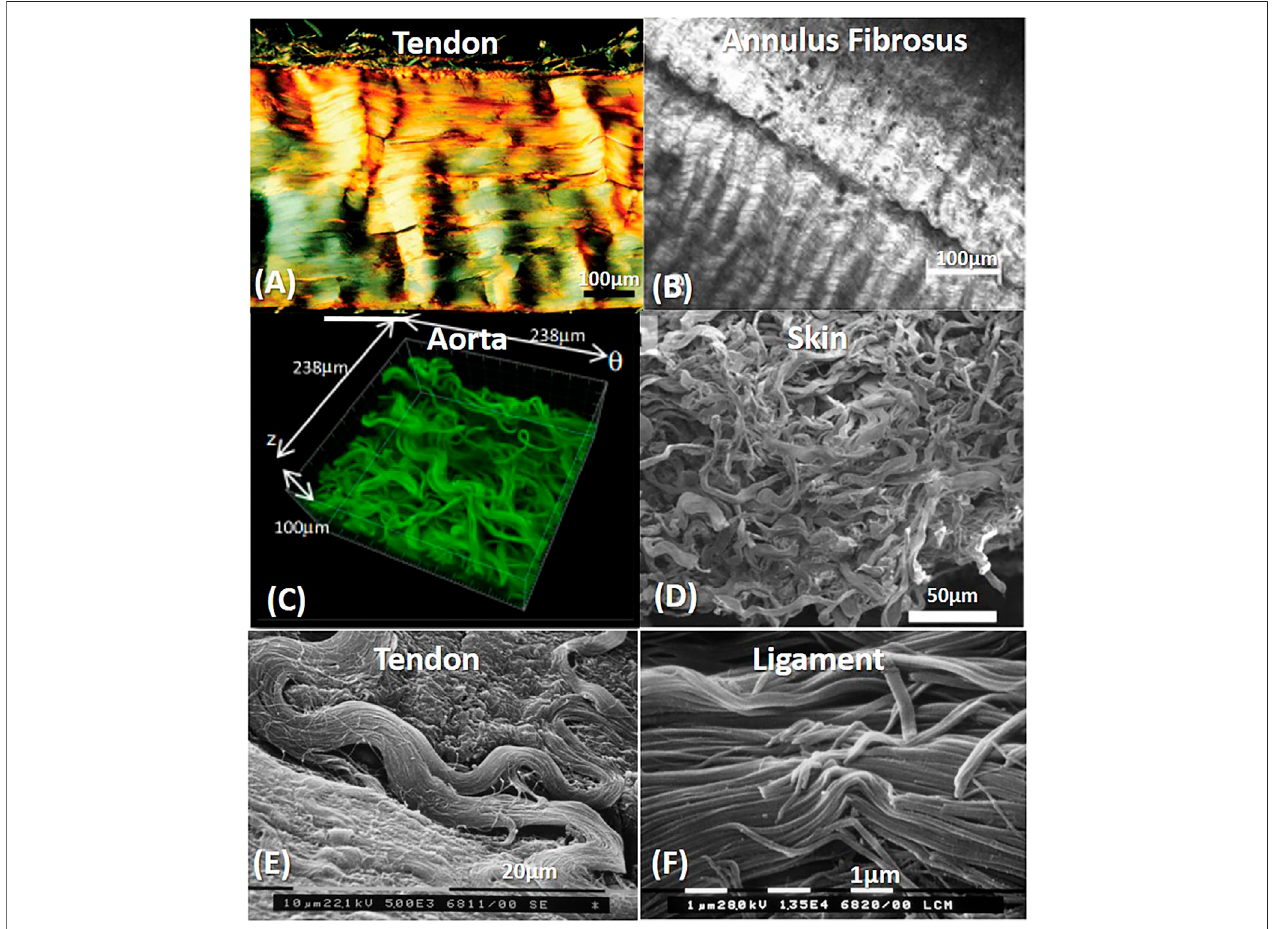
FIGURE 5 | Crimping and orientation patterns in different fi brous tissues: Tendons and ligaments (A , E , F) , Annulus Fibrosus (B) , Aorta (C) and skin (D) . (A) Polarized light micrograph of longitudinally sectioned rat Achilles tendon. Reprinted from Franchi et al. (2007) under CC-BY-3.0. (B) Annulus fi brosus second harmonic generation imaging of bovine tail AF. Reprinted from Vergari et al. (2017) under CC-BY-4.0. (C) Confocal laser scanning of the rabbit arterial adventitia. Reprinted from Rezakhaniha et al. (2012) under CC-BY-NC. (D) SEM arrangement of rabbit skin. Reprinted from Yang et al. (2015) under CC BY 4.0. (E) SEM image of a rat Achilles tendon, without fi brillary crimp when fi brils change their direction. Reprinted from Franchi et al. (2007) under CC-BY-3.0. (F) Fibril crimp in Rat medial collateral ligament (SEM). Reprinted from Franchi et al. (2010a) under CC-BY-3.0.